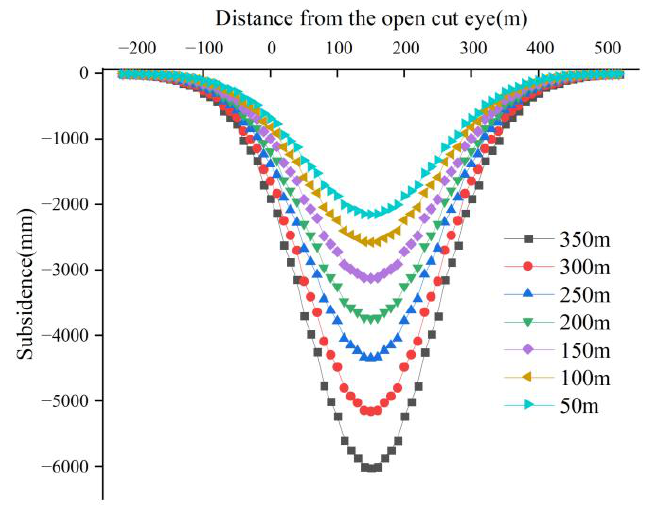
Figure 15. Numerical simulation of subsidence curve.